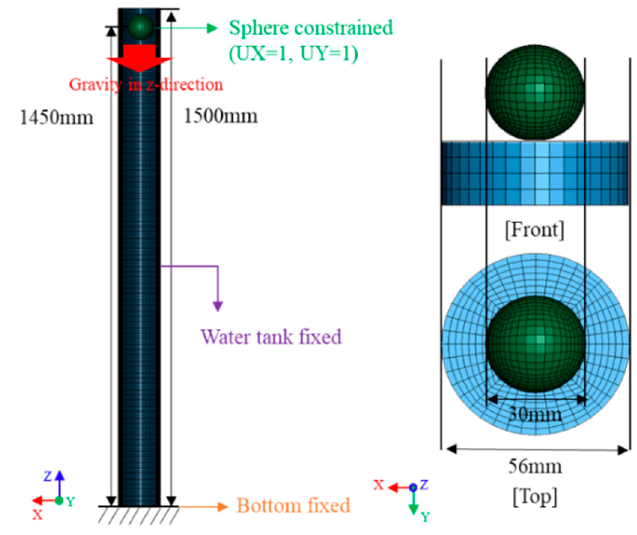
Figure 2. FE model for the water-dropping sphere.